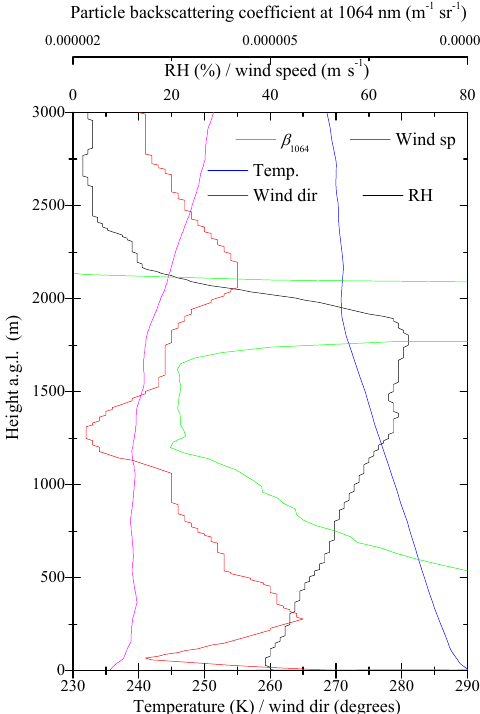
Figure 3. Vertical profile of β 1064 at 13:00UTC on 18 April 2013 (12:56:41–13:00:45UTC, green line), together with the vertical profiles of temperature (blue line), RH (black line), wind direction (red line) and speed (purple line) as measured by the radiosonde launched at 13:00UTC from the nearby station of Hambach (4km